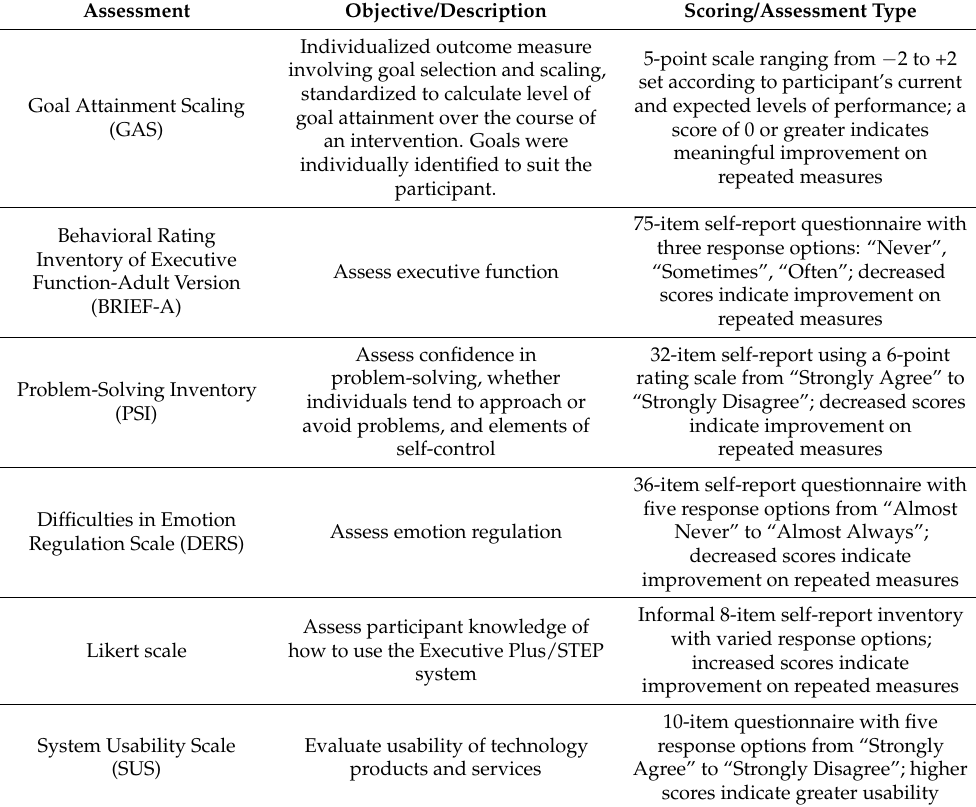
Table 2. Outcome